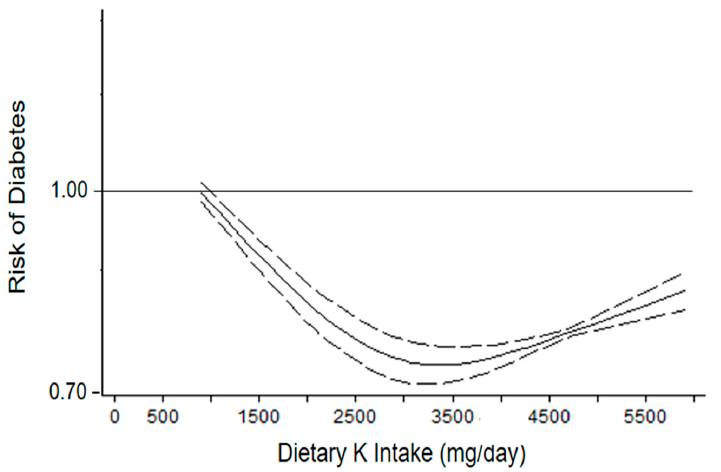
Figure 2. Dose–response association between potassium (K) intake and risk of diabetes (seven cohorts). Potassium intake was modelled with restricted cubic splines in a multivariate random- effects dose–response model (solid line). Dashed lines represent the 95% confidence intervals for the spline model.